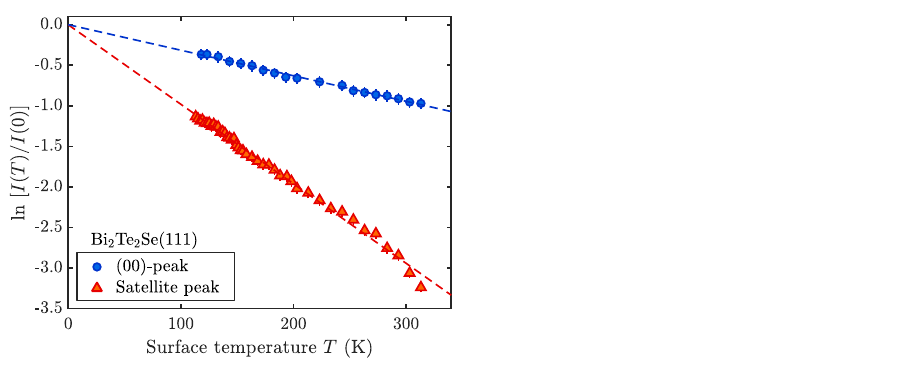
Figure A2. Debye–Waller plot of the temperature dependence for both the specular, as well as the satellite, peak at the left-hand-side of the specular peak. Therefore, Figure A1 shows a number of additional full diffraction scans with varying incident-beam energies. The full scan in Figure A1b, illustrates that the asymmetry between + g − g CDW and CDW for the cooled sample, as described in the main text, is also evident for the satellite peaks next to the first-order diffraction peaks. Small intensity variations occurring between the right- and left-hand side of the specular may be present due to misalignment effects; however, Figure A1b shows that such artefacts cannot explain the asymmetry between + g CDW and − g CDW . It should further be noted that the CDW peaks are very sensitive to the azimuthal orientation of the crystal, with the spin-allowed CDW periodicity of Bi 2 Te 2 Se(111) occurring only along Γ M, which clearly speaks against specular scattering. The temperature dependence of the peak intensities with the typical critical exponent is further strong evidence for the satellite peaks originating from a CDW. Finally, the semi-logarithmic plot (Figure A2) of the obtained temperature dependence for the diffraction intensities of the specular reflection (blue) and the satellite peak (red) clearly indicates the anomalous attenuation of the CDW satellite peak compared to the Debye attenuation of the specular peak. The data plotted in Figure A2 are further used for the derivation of the order parameter in Figure 4b in the main